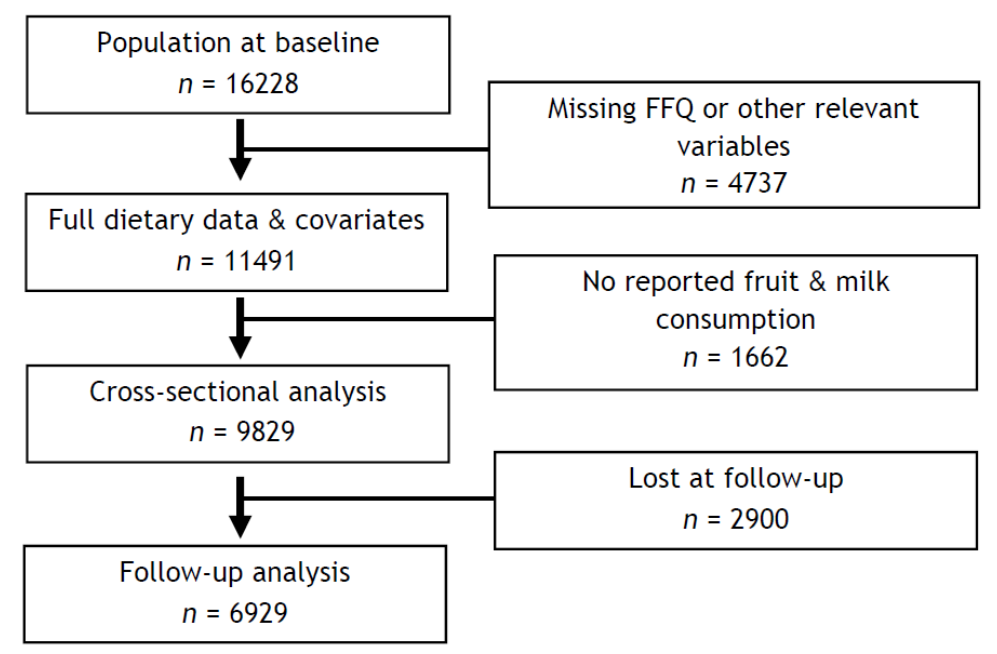
Figure 1. Participant flow chart.